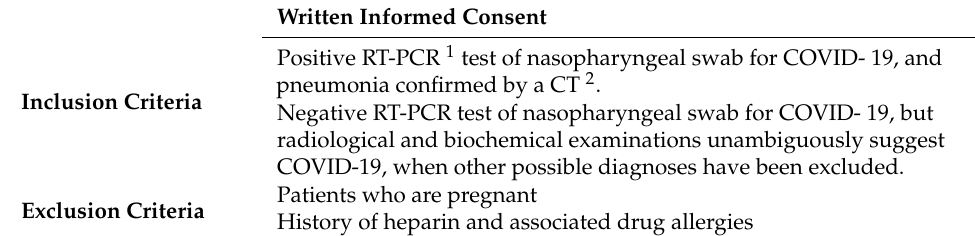
Table 1. Inclusion and Exclusion Criteria for All Patients.